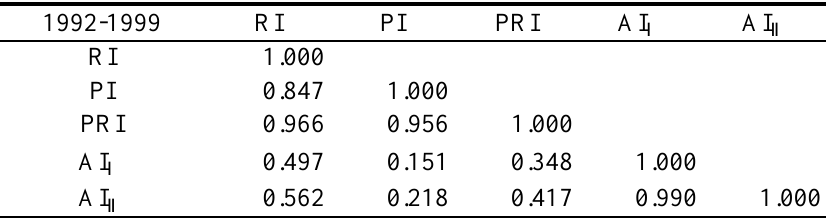
Table A.1: Correlation Coefficient between Fiscal Decentralization Indicators ( 1992–1999 ) Correlation